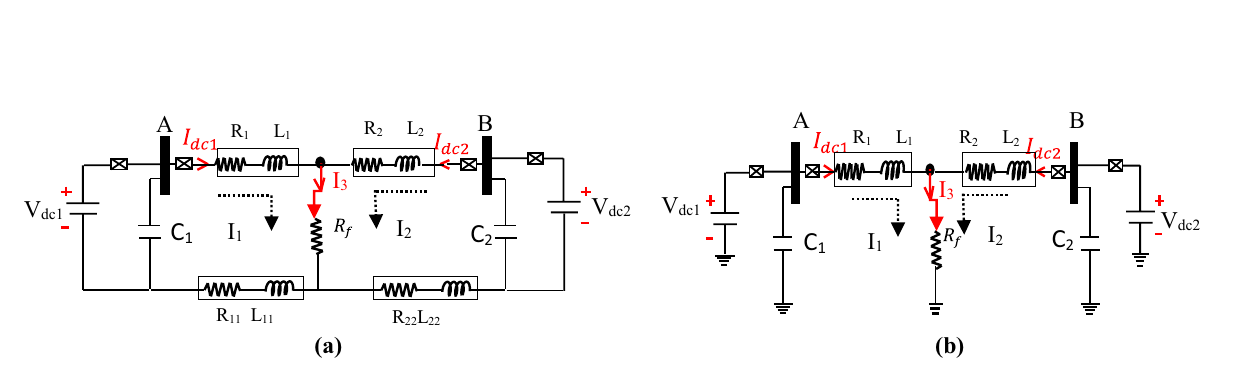
Fig. 3 Fault analysis a P-P fault and b P-P-G